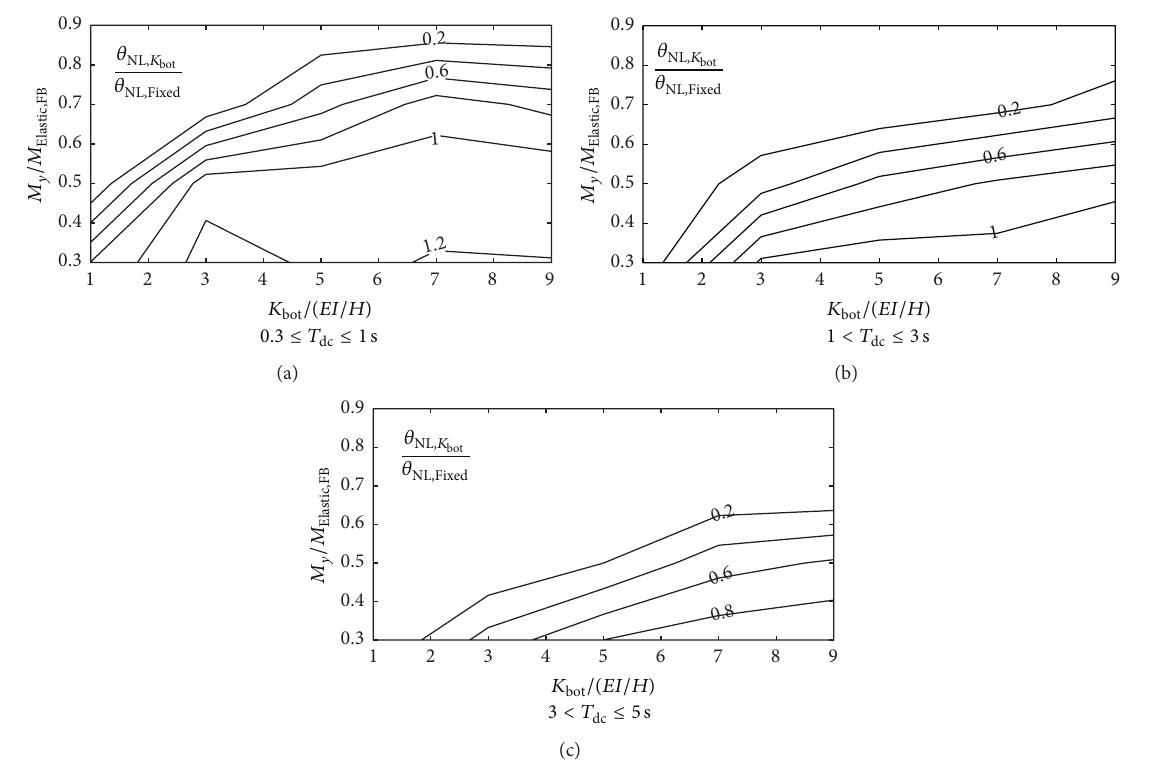
/𝜃 , for different base rotational stiffness ( 𝐾 NL ,𝐾 bot NL , Fixed